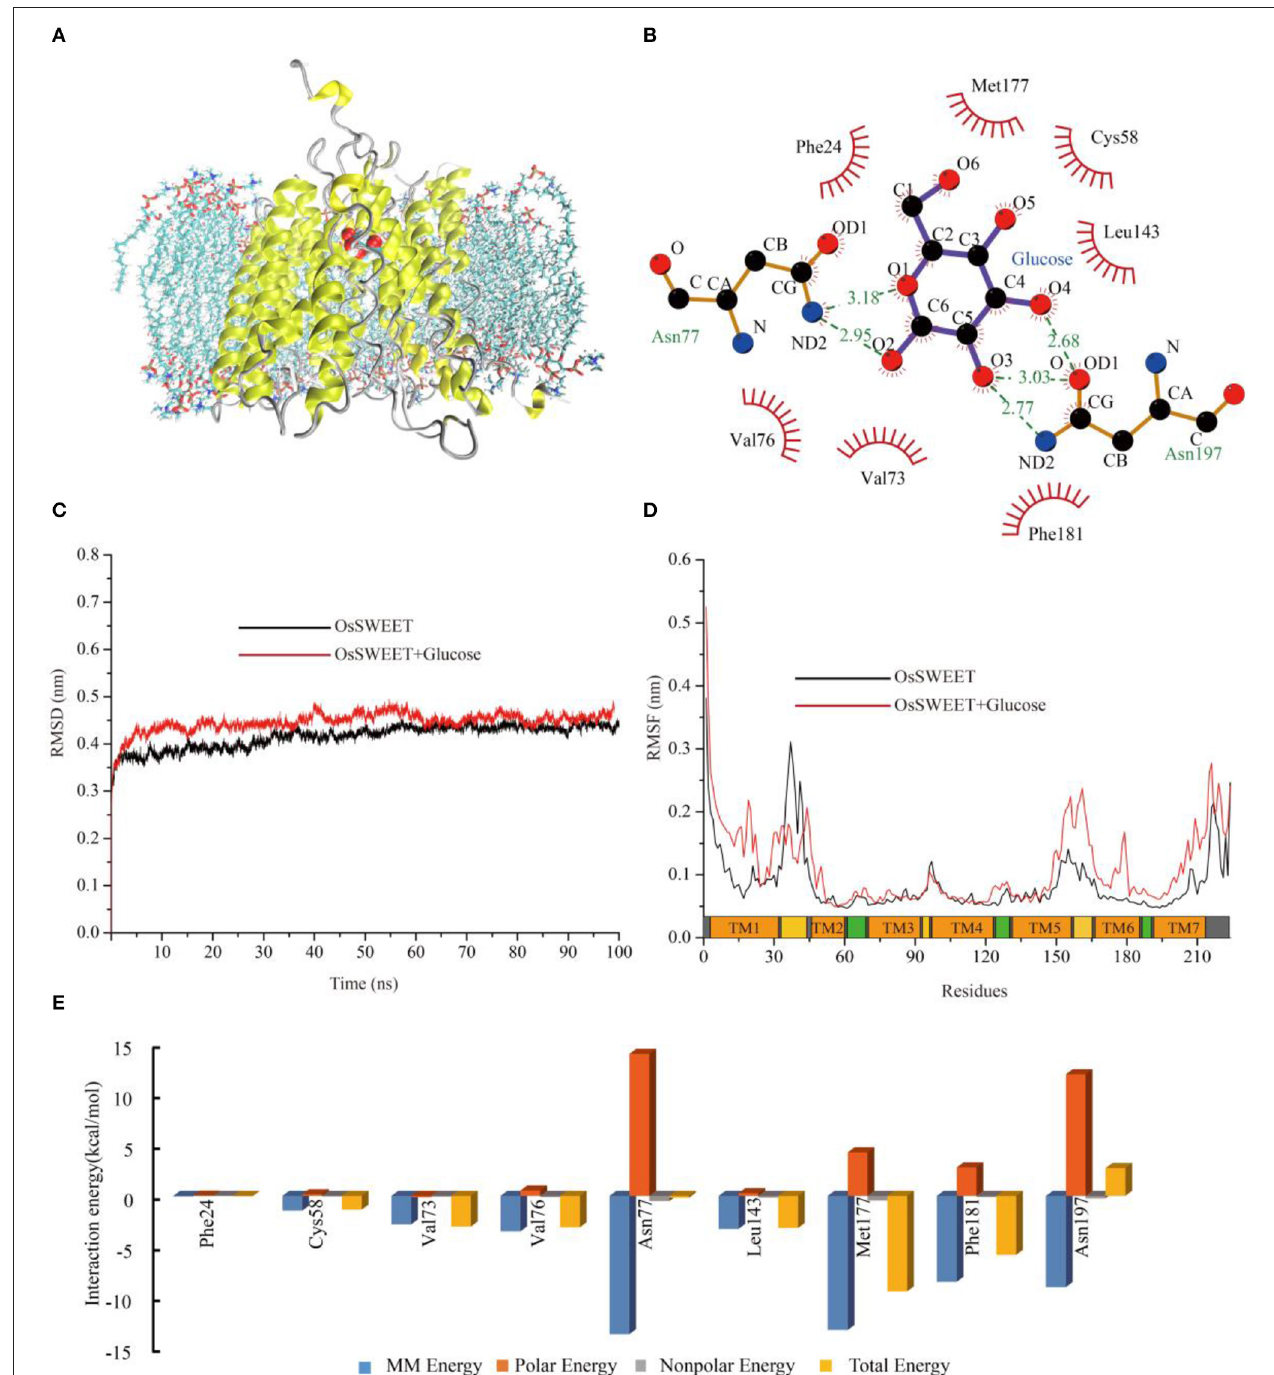
FIGURE 9 | Molecular dynamic analysis of OsSWEET2b. (A) Snapshot of a representative simulation system. The protein is shown in ribbons and glucose is shown in ball-and-stick form. (B) The glucose binding sites. A two-dimensional representation of ligand-protein interactions for the OsSWEET2b-glucose complex. (C) Backbone RMSDs are shown for OsSWEET2b and OsSWEET2b-glucose complexes at 300K. The black line indicates apo-OsSWEET2b; OsSWEET2b-glucose is shown in red. (D) RMSFs of the residue positions of apo-OsSWEET2b and OsSWEET2b-glucose at 300K. apo-OsSWEET2b and OsSWEET2b-glucose are shown in black and red, respectively. (E) The decomposition of the binding energy on a per-residue basis at the binding sites of the OsSWEET2b-glucose complex. (Blue bars: molecular mechanics energy; orange bars: polar energy; gray bars: non-polar energy; yellow bars: total energy).